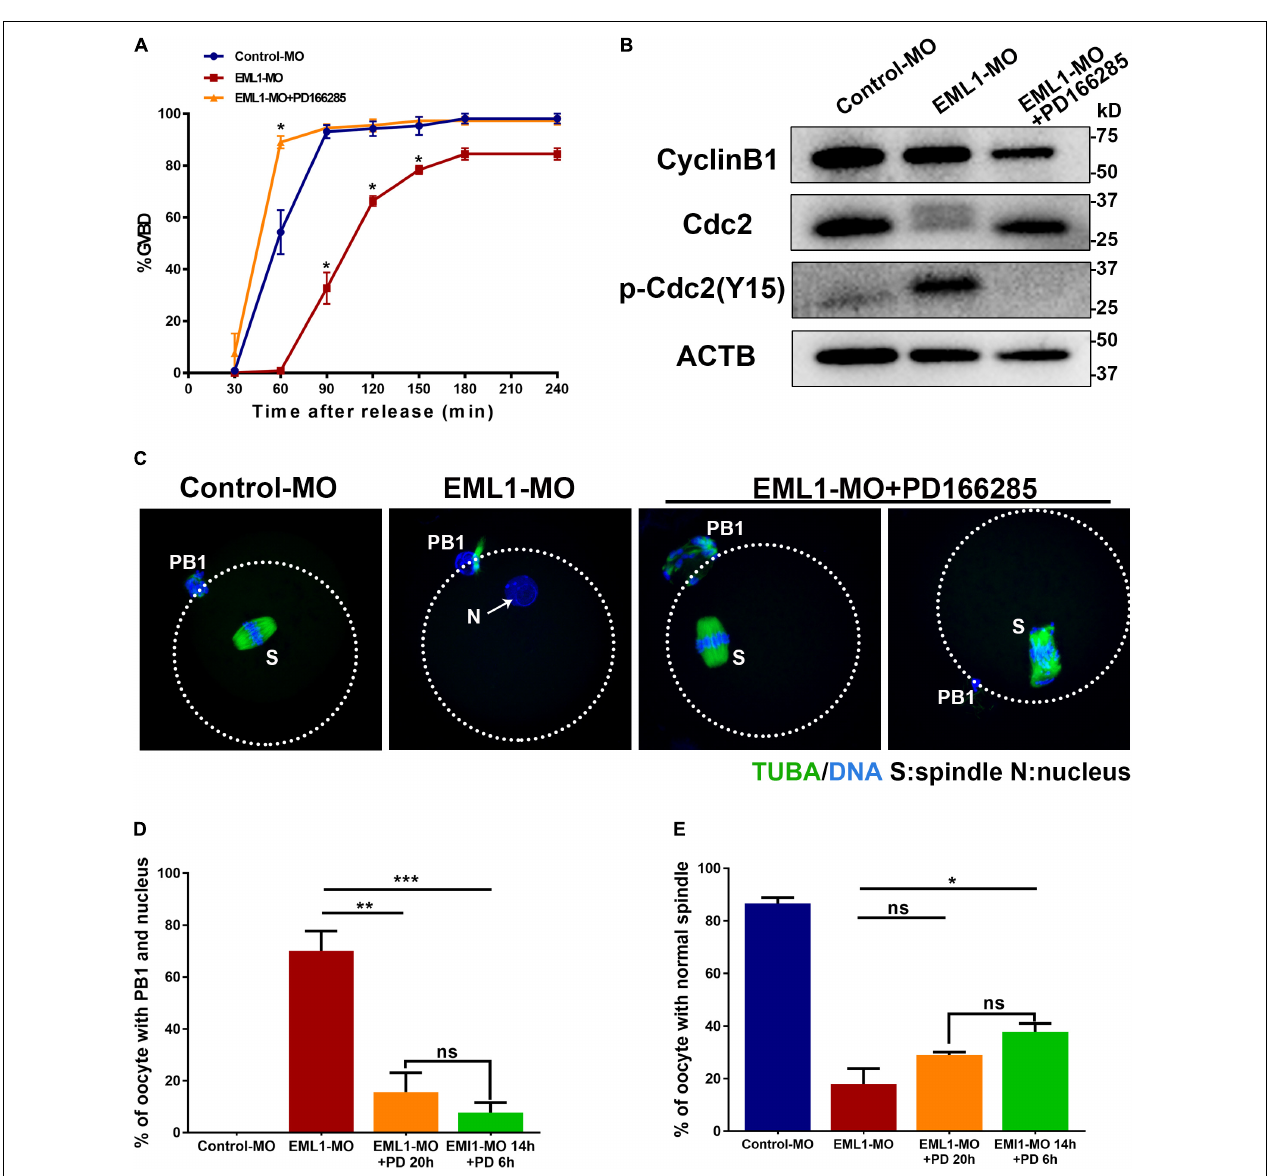
FIGURE 9 | Activation of MPF by inhibitors of WEE1/2 kinases rescues the defects of meiotic progression in EML1-knocked down oocytes. (A) Oocytes microinjected with Control-MO and EML1-MO were first maintained at GV stage for 20 h, and then transferred to maturation medium with (for EML1-MO group) or without (for Control-MO group) the supplementation of the inhibitor of WEE1/2 kinases, PD166285, to allow for maturation. Oocyte GVB was scored during the culture. * P < 0.05, compared with the Control-MO group. (B) Western Blot analysis of the changes in the levels of CCNB1, pCDK1-Y15, and CDK1 in the EML1-knocked down oocytes that were treated with PD166285. ACTB was used as the loading control. Lysate from 50 oocytes was loaded in each lane. The representative gel images of three independent experiments are shown. ( C–E) Assessment of the effect of PD166285 on the progression of meiosis to MII in EML1-knocked down oocytes. Oocytes microinjected with Control-MO and EML1-MO were first maintained at GV stage for 24 h. Then the EML1-MO oocytes were split into two groups, one of which was transferred to maturation medium supplemented with PD16628S and directly cultured for 20 h, while the other one was first transferred to maturation medium without PD166285 for 14 h, and then in the PD166285-supplemented medium for another 4 h culture. PBE, PN formation, and spindle morphology were then scored and analyzed. Representative images of the oocytes with the microtubules labeled with anti-tubulin antibody (green) and DNA stained with Hochest (blue) are shown in panel (C) . Scale Bar = 20 µ m. Quantification of the percentages of oocytes with PB1 and PN, and those with normal MII-spindles are shown in panels (D,E) , respectively. * P < 0.05, ** P < 0.01, *** P < 0.005, compared with the EML1-MO group. ns denote no significant difference between the two groups